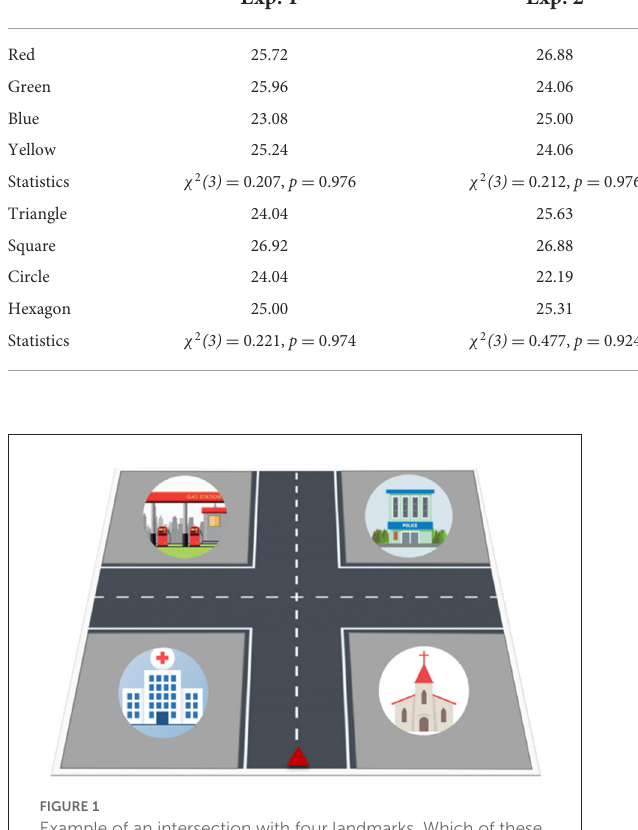
squares, trapezoids, triangles, circles, as well as blue,